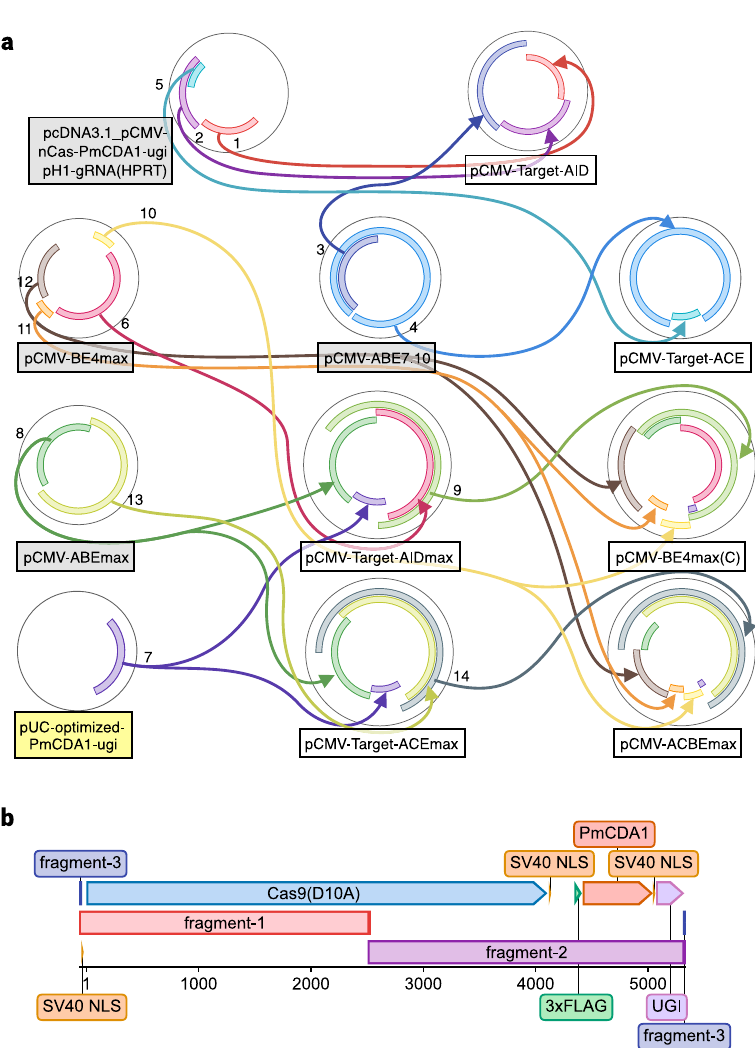
Fig. 4 Base editor plasmid constructions. a The construction lineages of base editor plasmids with recycling of their DNA sequences. The plasmid names with gray, yellow, and white boxes represent those obtained from Addgene, newly synthesized, or described by QUEEN in this study, respectively. b Recovery of the “ Cas9(D10A) ” feature after joining two fragments each from a different DNA object having the